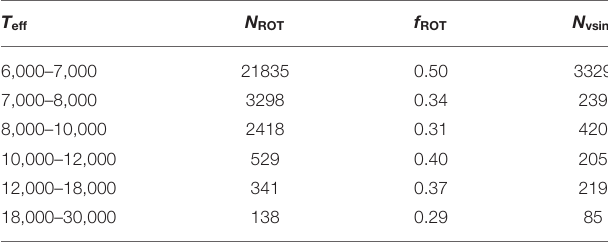
TABLE 1 | Number of ROT stars within the given T eff range, N ROT . T eff N ROT f ROT